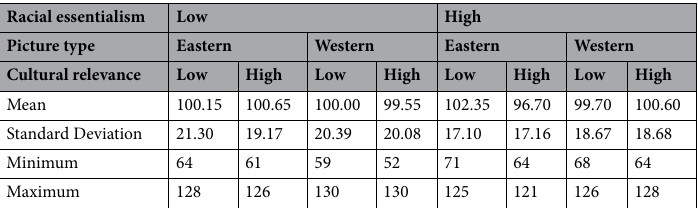
Table 1. Numbers of trials in the ERP